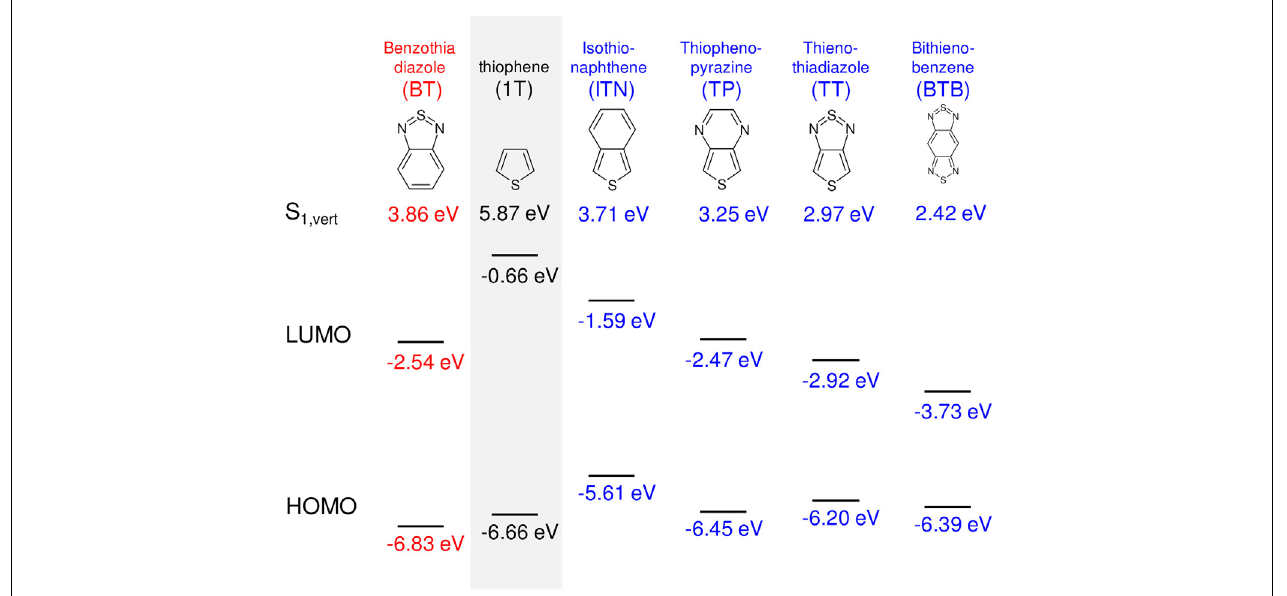
FIGURE 3 | Examples of small bandgap monomers, with calculated HOMO and LUMO levels as well as E vert obtained at the (TD-)DFT B3LYP/6-311G ∗ level of theory.